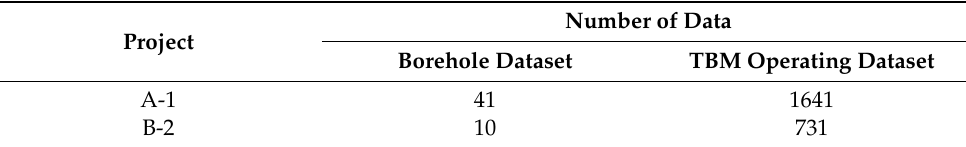
Table 2. The size of the dataset for borehole and TBM operating parameters.